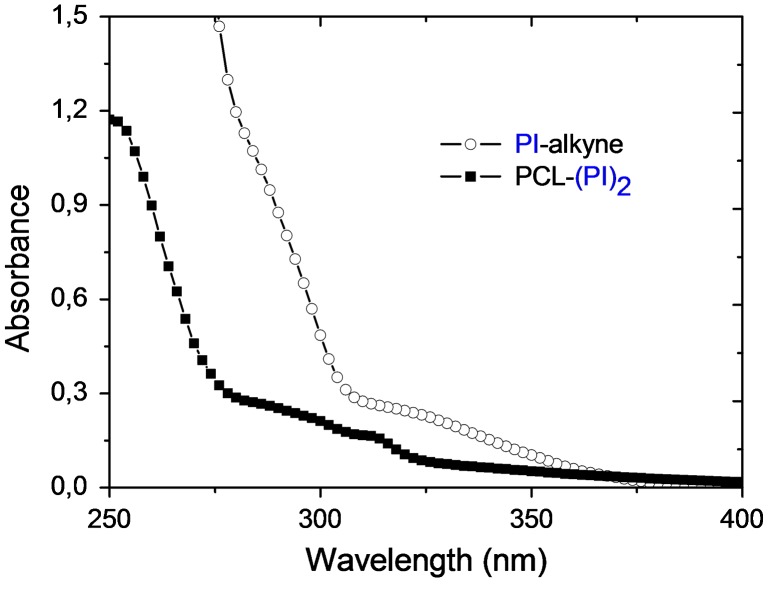
UV absorption spectra of PI-alkyne (6.15 × 10−4 mol L−1) and PCL-(PI)2 (0.16 g L−1) in CH2Cl2.